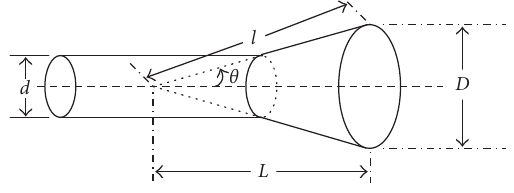
Figure 1: Geometry of smooth-walled conical